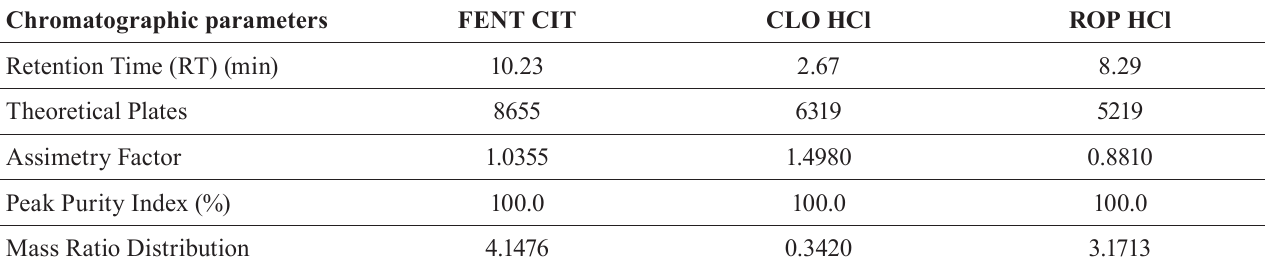
TABLE I - C hromatographic parameters developed for the method of quantification of FENT CIT, CLO HCl and ROP HCl by HPLC/DAD Chromatographic